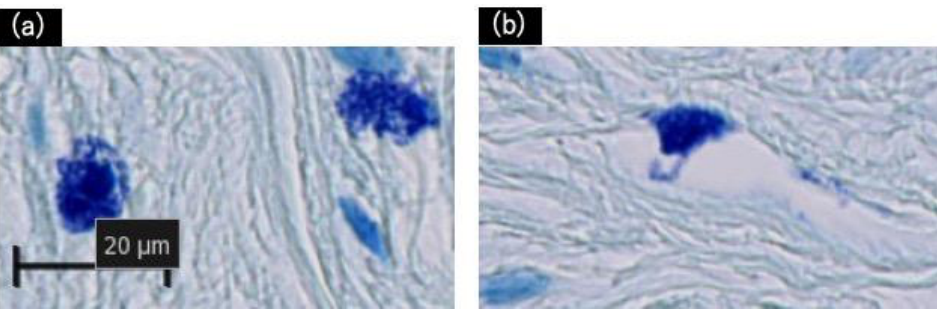
Figure 3. Histological validation of degranulation from mast cells with toluidine blue staining. ( a ) Positive: Mast cells have distinctly degranulated particles. ( b ) Negative: Granulation is not clearly observed. Scale bar = 20 µm .